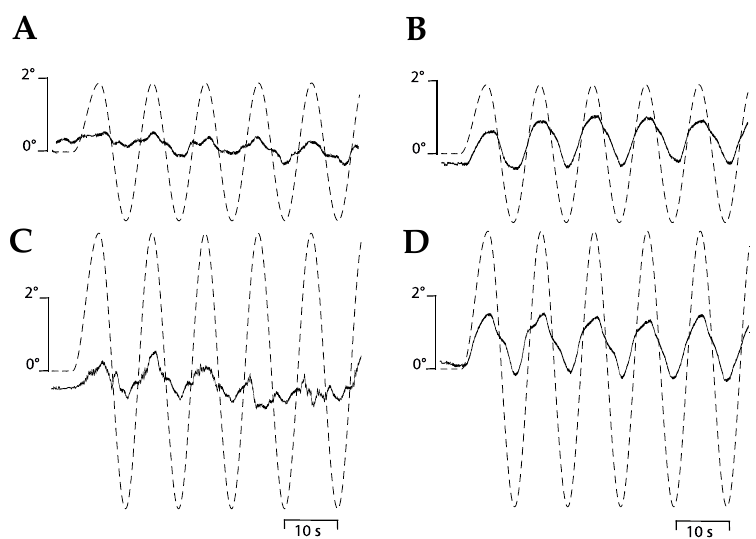
Figure 5. Robot balancing tests. Robot Lucy successfully balanced in the body sagittal plane when presented with support surface tilts in the body sagittal plane of peak-to-peak ( A ) 4° and ( C ) 8°. Body COM sway with the addition of an eccentric weight fixed to the robot’s anterior pelvis (see Figure 2A). This increased the sway responses to the peak-to-peak ( B ) 4° and ( D ) 8° support surface tilts, but the ( B and D ) tilt disturbance was still well compensated. The effect owes to the ‘contact force compensation’ of the robot’s disturbance estimation and compensation (DEC) system. Balance was lost when this DEC mechanism was inactivated (not shown). This experiment mimics a situation where the exoskeleton user, while exposed to support surface tilts, would change the body weight distribution by raising the arms, leaning the upper body or lifting with a hand an external weight.